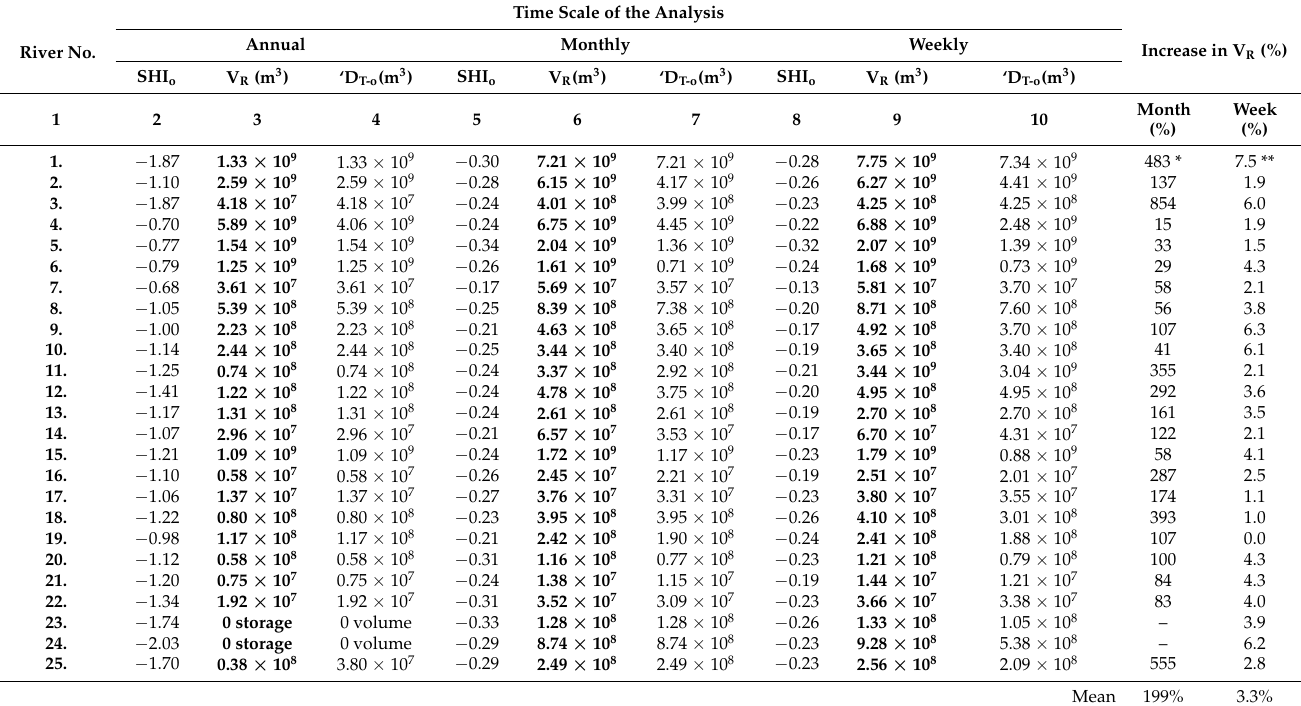
Table 3. Comparison of V R and D T-o at the draft level of 0.75 µ o : annual, monthly and weekly scales.